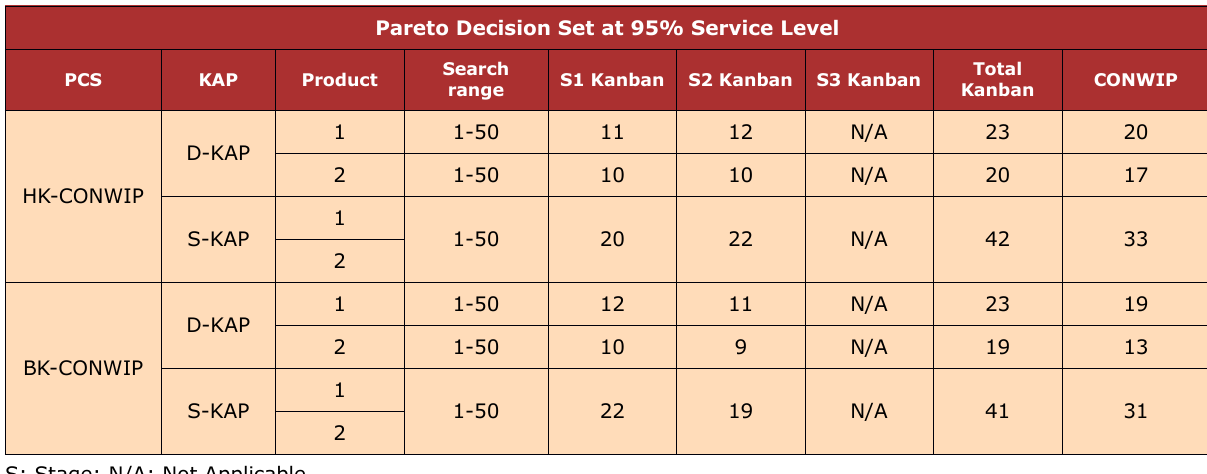
Table 5. Case-1 Search space and optimal values of PCS+KAP at 95% service level